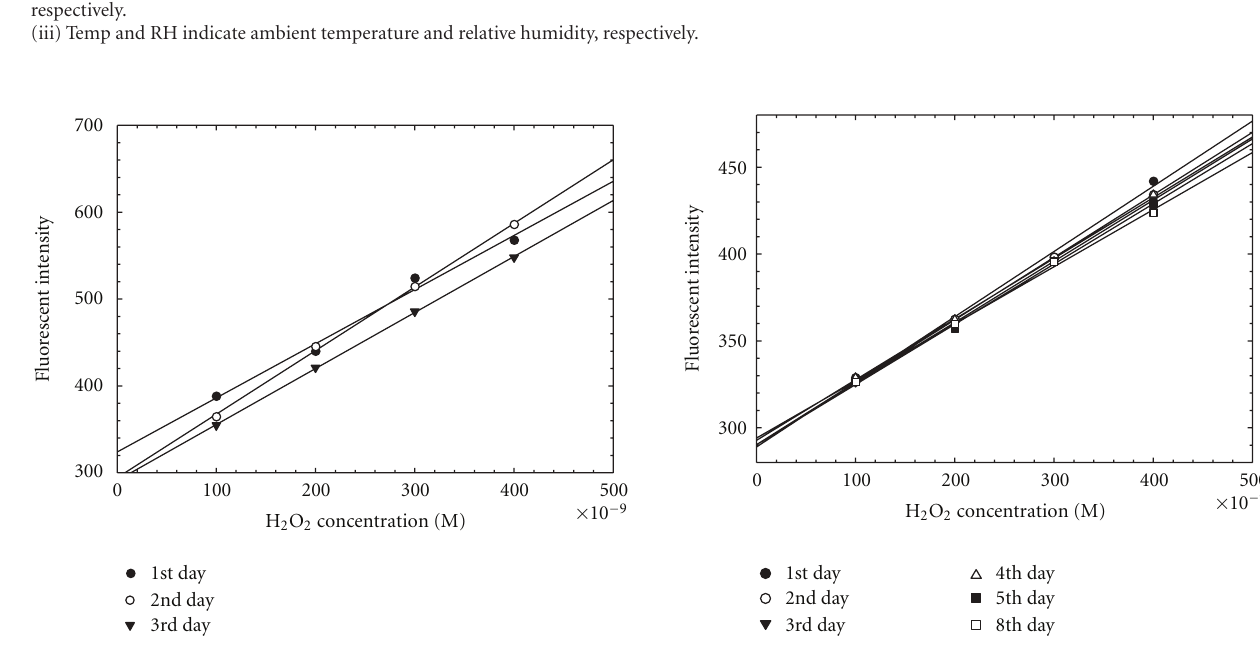
Figure 5: Stability of 5 μ M DCFH at room temperature. Figure 6: Stability of H 2 O 2 standard solutions at room tempera-